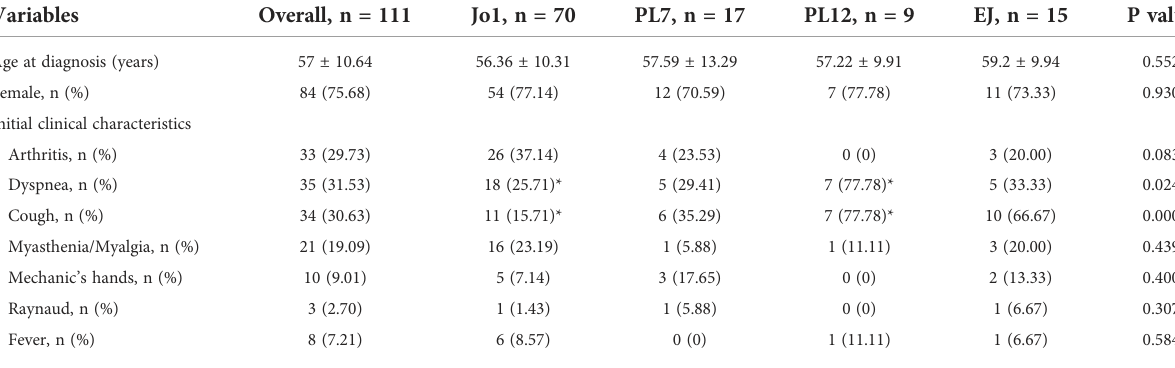
TABLE 1 Comparison of demographic and clinical features of patients with ASS-ILD.